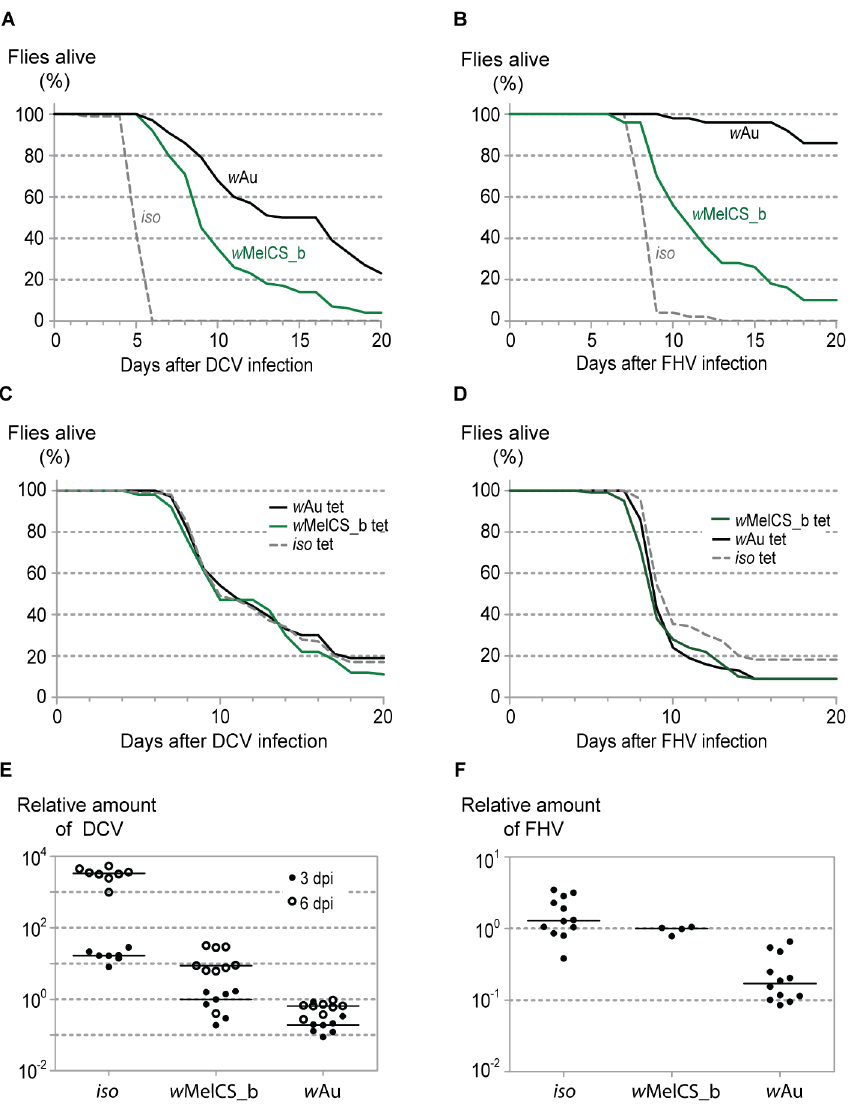
Figure 1. w Au provides more antiviral resistance than w MelCS_b in D.melanogaster . (A) One hundred Wolbachia -free iso , w Au and w MelCS_b infected male flies were pricked with DCV (10 9 TCID 50 /ml) and survival was followed daily. This experiment was repeated twice and statistical analysis was performed on the data from all 3 repetitions (Figure S1A). (B) Fifty Wolbachia -free iso , w Au and w MelCS_b infected male flies were pricked with FHV (10 8 TCID 50 /ml) and survival was followed daily. This experiment was repeated and statistical analysis was performed on the data from both repetitions (Figure S1B). (C) One hundred males from w Au, w MelCS_b and iso tetracycline-treated lines were pricked with DCV (10 7 TCID 50 /ml) and survival was followed daily. This experiment was repeated and statistical analysis was performed on the data from both repetitions (Figure S1C). (D) One hundred males from w Au, w MelCS_b and iso tetracycline-treated stocks were pricked with FHV (10 8 TCID 50 /ml) and survival was followed daily. For data analysis see Figure S1D. (E) Wolbachia -free iso , w Au and w MelCS_b carrying male flies were pricked with DCV (10 9 TCID 50 /ml) and collected 3 and 6 days later for RNA extraction and RT-qPCR. Relative amounts of DCV were calculated using host Rpl32 mRNA as a reference and presented values are relative to median of w MelCS_b samples 3 dpi. Each point represents a replicate (ten males per replicate, 8 replicates per Drosophila line per time point), and lines are medians of the replicates. DCV loads are significantly different between the lines with w Au and w MelCS_b both 3 dpi (pairwise Wilcoxon rank sum test, p =0.03) and 6 dpi (pairwise Wilcoxon rank sum test, p , 0.001). (F) Wolbachia -free iso , w Au and w MelCS_b carrying male flies were pricked with FHV (10 9 TCID 50 /ml) and collected 3 days post infection for RNA extraction and RT-qPCR. Relative amount of virus were calculated using host Rpl32 mRNA as a reference and presented values are relative to median of w MelCS_b samples. Each point represents a replicate (ten males per replicate), and lines are medians of the replicates. FHV loads are significantly lower in flies with w Au comparing to flies with w MelCS_b (pairwise Wilcoxon rank sum test, p